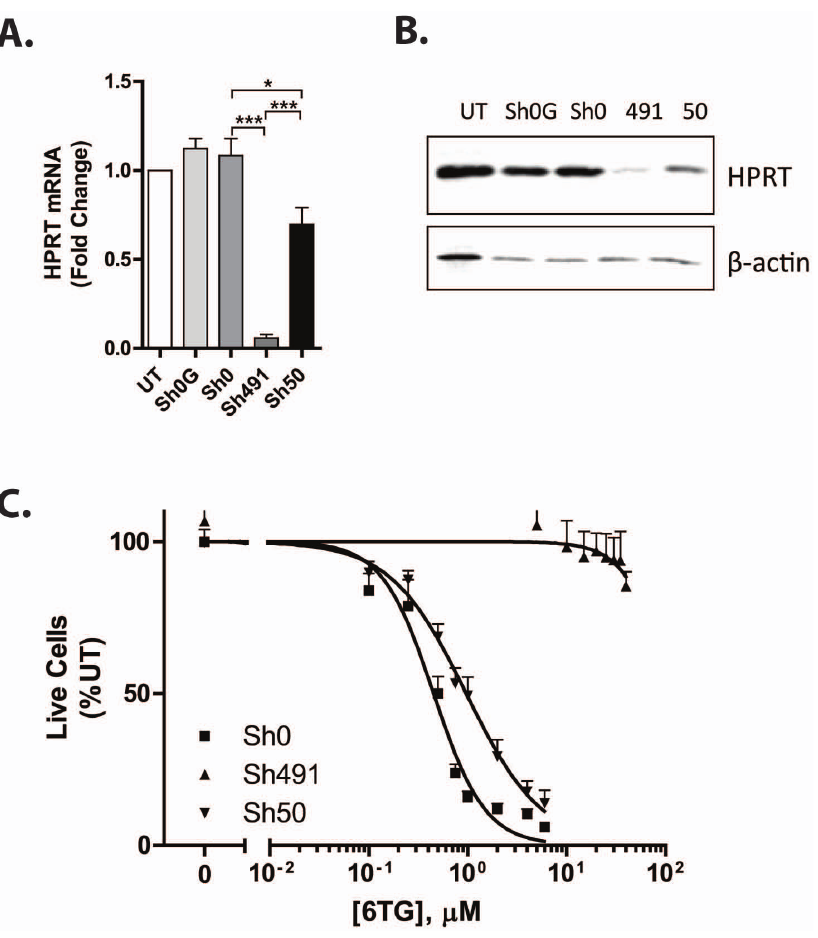
Figure 1. Knockdown of HPRT confers resistance to 6TG in human hematopoietic cells. Molm13 cells were transduced with lentiviral vectors expressing non-silencing control sequences (sh0 and sh0G) or shRNAs directed against HPRT (sh491 and sh50) and selected in puromycin. A & B. Construct 491 most effectively knocks down HPRT. The extent of knockdown of HPRT was measured by reverse-transcription, real-time PCR with primers specific for HPRT (A) and western blotting (B). Constructs 491 and 50 efficiently knocked down HPRT, as compared to untransduced controls. The extent of knockdown was significantly greater with construct 491. C. Construct 491 provides the greatest resistance to 6TG. Transduced cells were treated with increasing doses of 6TG, and the number of live cells was measured by flow cytometry and propidium iodide exclusion. Construct 491 provided the best resistance to 6TG.